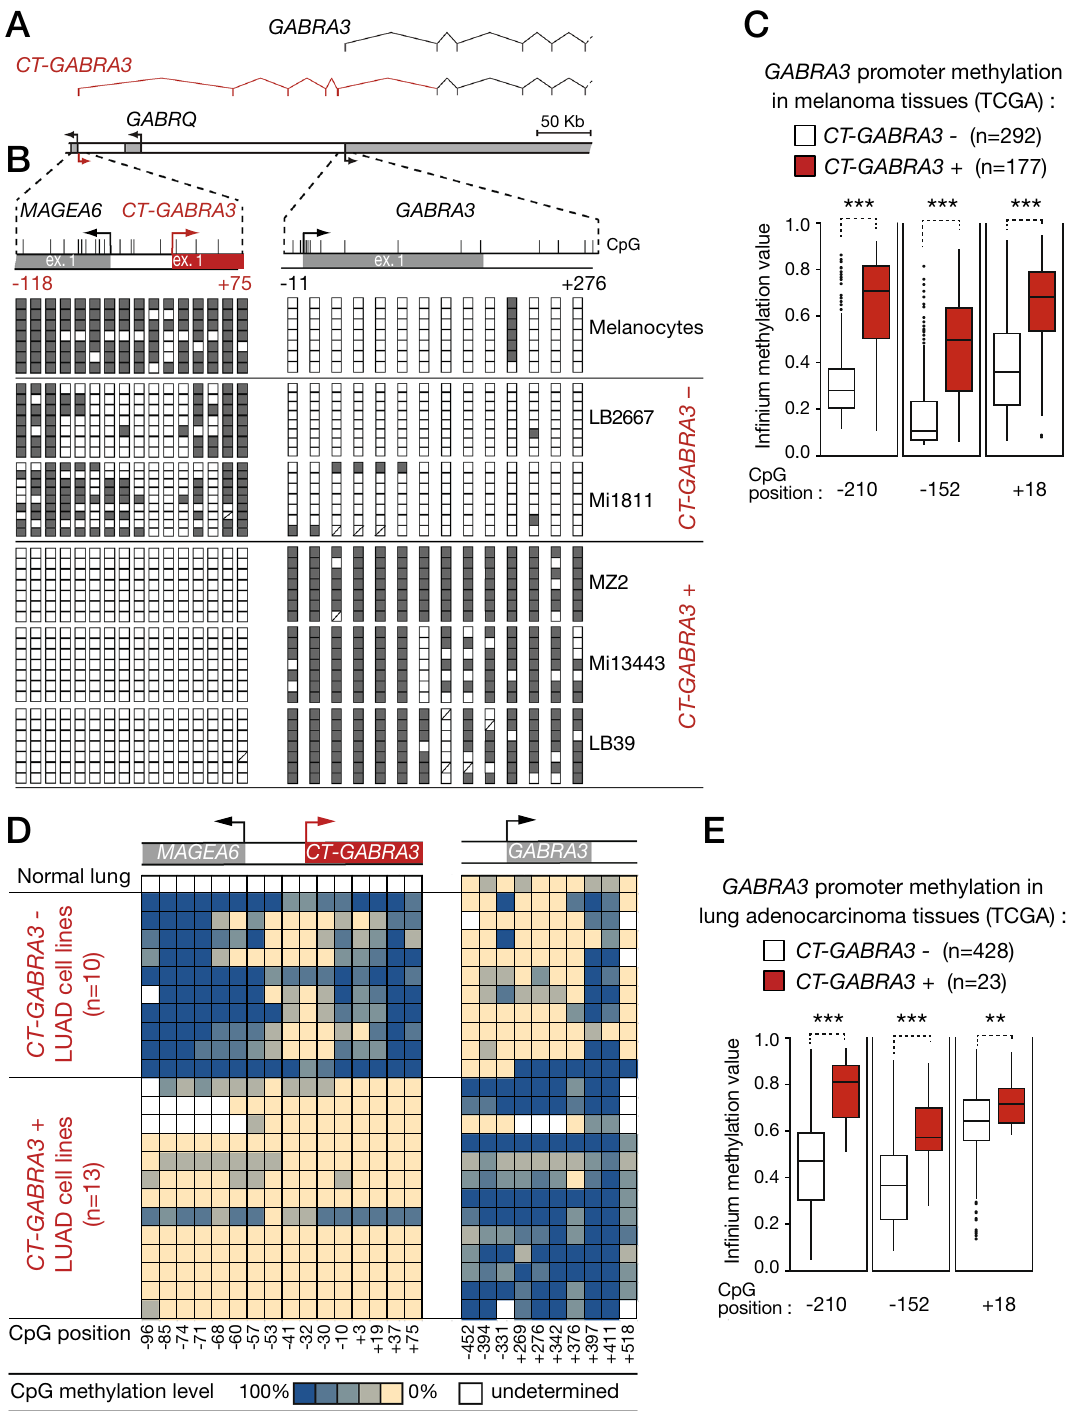
Figure 1. DNA hypomethylation of the MAGEA6 / CT-GABRA3 promoter correlates with DNA hypermethylation of the GABRA3 promoter in melanoma and lung adenocarcinoma. ( A ) Schematic representation of the GABRA3 locus, with broken arrows indicating transcription start sites. The exon/intron structure of CT-GABRA3 and GABRA3 transcript variants is shown above. ( B ) Clonal bisulfite sequencing of MAGEA6 / CT-GABRA3 and GABRA3 5 ′ -regions. Vertical bars indicate location of CpG sites with positions relative to the transcription start site. Open and filled squares represent unmethylated and methylated CpG sites, respectively, and each row represents a single clone. CT-GABRA3 expression status (+) or (−) in melanoma cell lines is indicated. ( C ) Melanoma tissue samples from the TCGA were grouped according to CT-GABRA3 expression status (inferred from RNA-seq data), and the methylation level of three CpG sites embedded within the GABRA3 5 ′ -region (position relative to TSS) were determined through the analysis of Infinium methylation data (probe intensity ratio). *** Welch’s t-test, adjusted p -value < 0.001 ( D ) Methylation level of CpG sites within the MAGEA6 / CT-GABRA3 and GABRA3 5 ′ -regions in lung adenocarcinoma (LUAD) cell lines (CpG positions are expressed relative to the TSS). Methylation levels were calculated on the basis of Methyl-seq data from the DBTSS database. CT-GABRA3 expression status in LUAD cell lines was inferred from RNA-seq data. ( E ) The same analysis as described in D was applied to lung adenocarcinoma samples from the TCGA. ** and ***Mann–Whitney test, adjusted p -value < 0.01 and < 0.001,